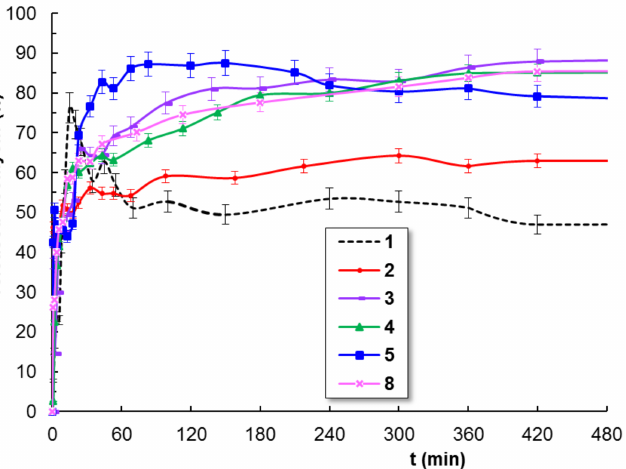
Figure 9. In vitro cumulative release profile of neomycin (% of total incorporated amount) from the hydrogel samples at 37 ◦ C, pH = 7.4. Table 2. The parameters that describe the kinetics of neomycin release from hybrid